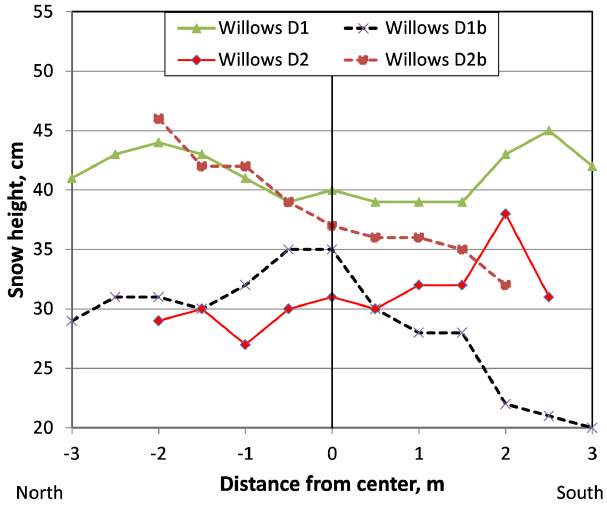
Figure 2. Effect of the presence of isolated bushes on snow height in May 2015. The origin is at the center of the bush. Snow height was then measured uphill (south, positive values) and downhill of the bush. The four bushes studied were given arbitrary